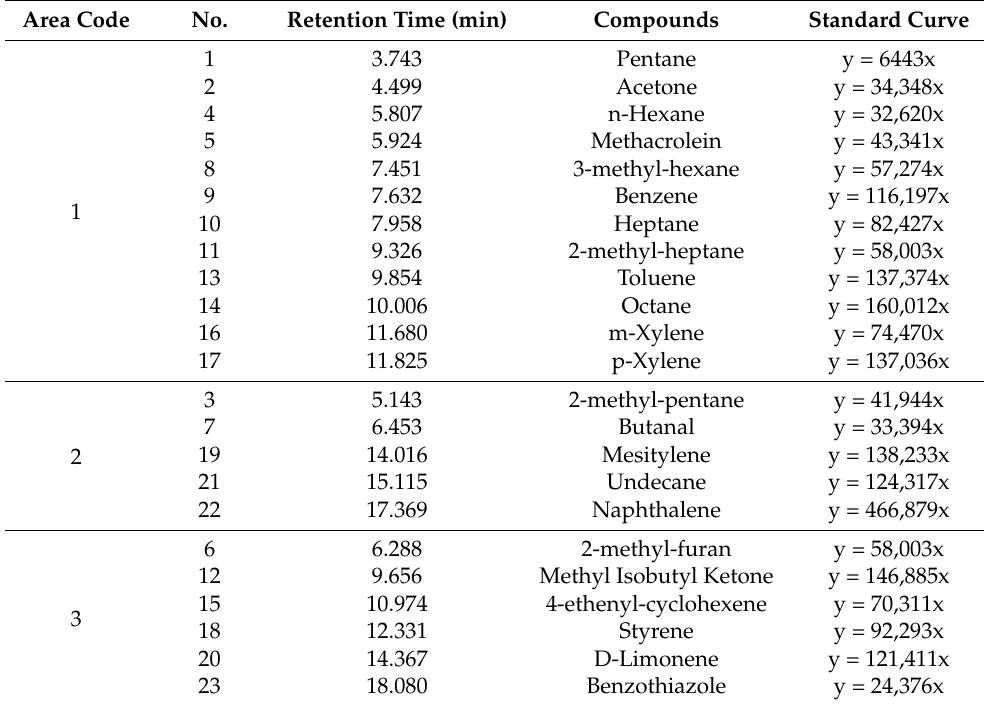
Table 3. The 23 VOCs fingerprint compounds from 3 areas and their standard curves for the GC-MS. Area Code No. Retention Time (min) Compounds Standard